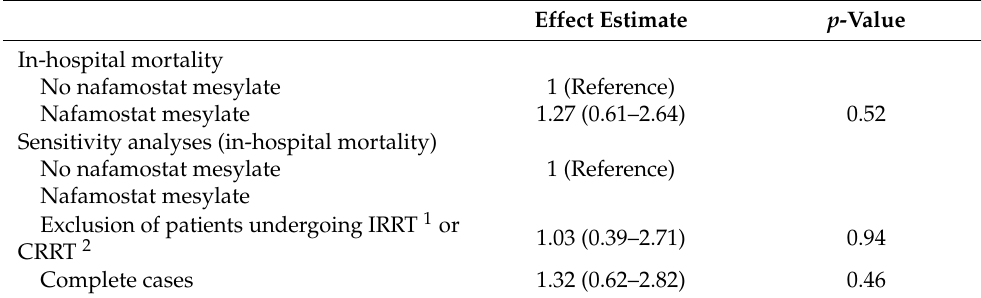
Table 3. Study outcomes after propensity score matching.